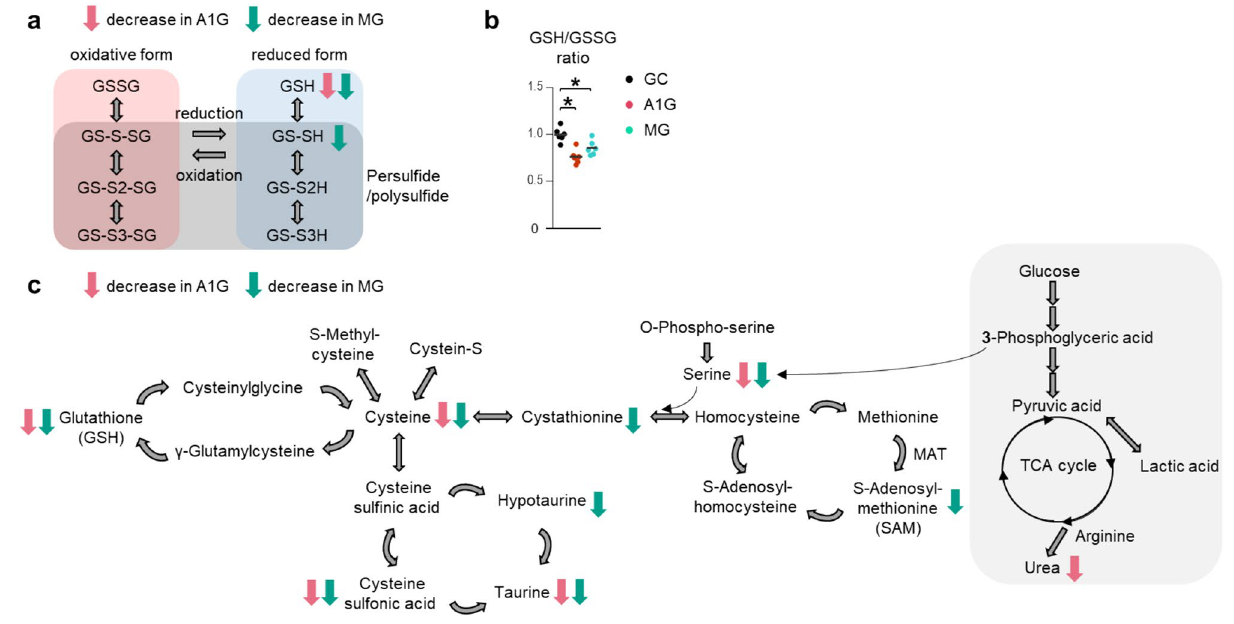
Figure 2. Downregulation of sulfur compounds in the livers of mice exposed to a spaceflight. ( a ) An illustration of the reduction and oxidization network of glutathione. Glutathione (GSH), glutathione disulfide (GSSG), and their persulfidated derivatives GS-SH, GS-S2H, GS-S3H, GS-S-SG, GS-S2-SG, and GS-S3-SG. or indicates a significant decrease in A1G or MG mice compared to GC mice. GC, control mice on Earth; A1G, mice under artificial earth gravity in space; MG, mice under microgravity in space. ( b ) The ratio of the relative amount of GSH to GSSG. Each horizontal bar represents the mean. Dot plots were made using GraphPad Prism 6.07 for Windows, GraphPad Software, San Diego, CA USA, www. graph pad. com. ( c ) An illustration of the metabolic network of sulfur compounds in mammals. and between compounds indicates metabolic reactions in mammals. or indicates a decrease in A1G or MG mice compared to GC mice. MAT, methionine adenosyltransferase. * P < 0.05. Comparisons of parameters were performed with one-way ANOVA followed by Dunnett’s test for multiple comparisons ( n = 6